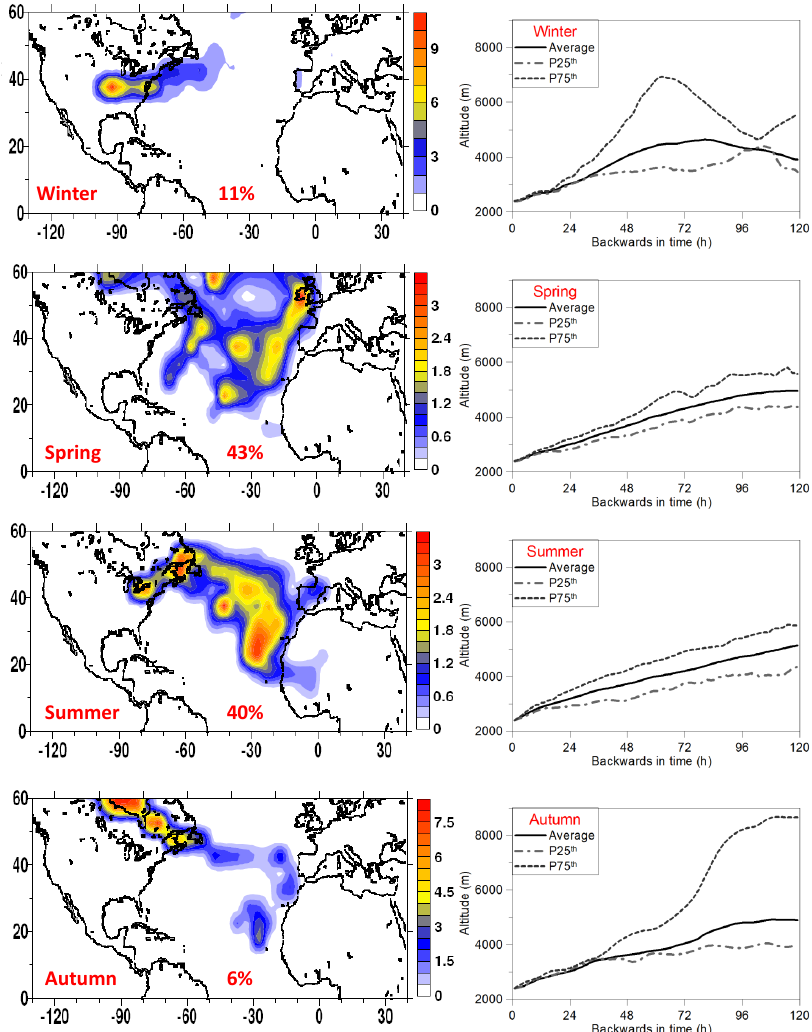
Fig. 11. Residence times and transport pathways of air masses with daily 7 Be > 8mBqm − 3 and corresponding averaged back- ward trajectories heights for each season of the year. Color bars in- dicate the residence time in arbitrary units. In backward trajectory heights the mean value, P25th and P75th are plotted.